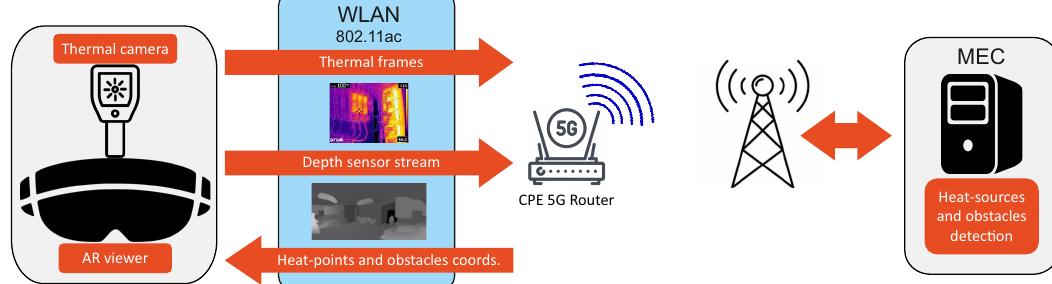
Figure 1. The proposed Advanced Assistive Maintenance framework. An AR viewer, equipped with a depth sensor and a thermal camera, sends multi-sensor information over an IEEE 802.11ac WLAN to a customer-premises equipment (CPE). The CPE is then connected through a 5G link to a Multi-access Edge Computer (MEC) that processes the received data to detect heat-sources and obstacles. Coordinates of detected points are sent back to the helmet and visualized in real-time. The same connection is also used for an interactive video